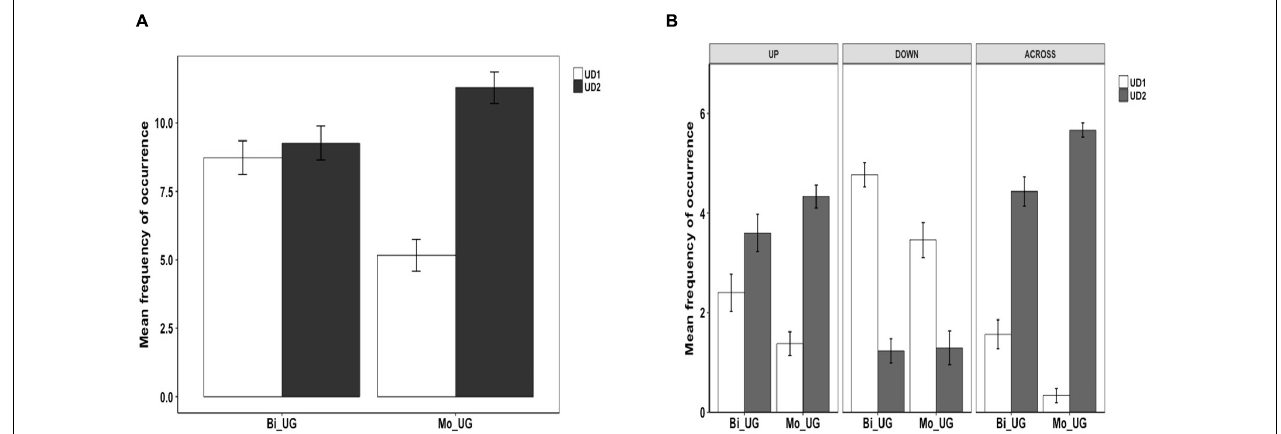
FIGURE 5 | Utterance density in